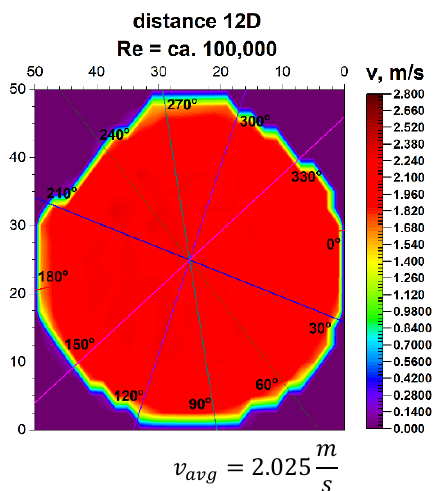
Figure 24. Projection on the velocity block at the distance 12D from the disturbance with marked cross-sections for Re ≅